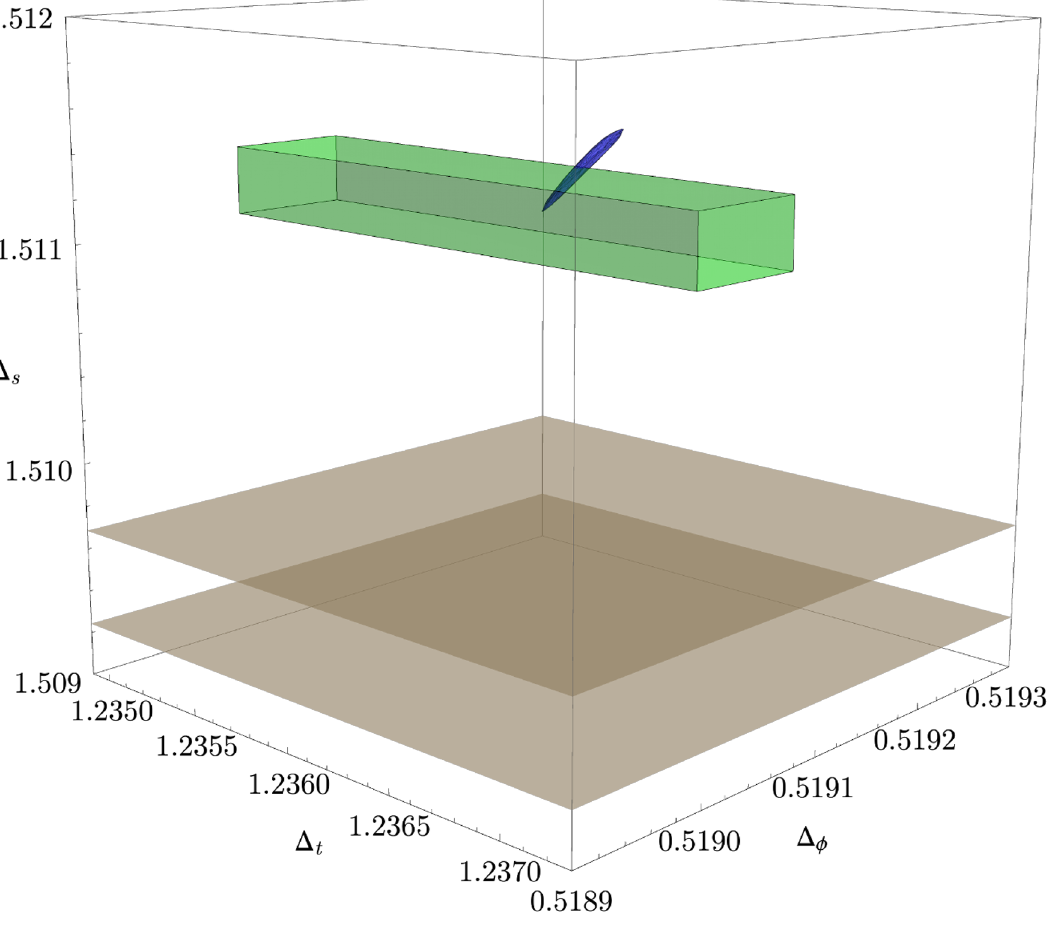
Figure 2 . 3d region corresponding to our new O(2) island using the f (cid:30) i ; s; t ij g system and OPE scans at (cid:3) = 43 (blue). The result is compared with the best (cid:12)t values of (cid:1) s to 4 He data [85] (brown planes) and the region for f (cid:1) (cid:30) ; (cid:1) s ; (cid:1) t g reported by the Monte Carlo studies [86, 87] (green